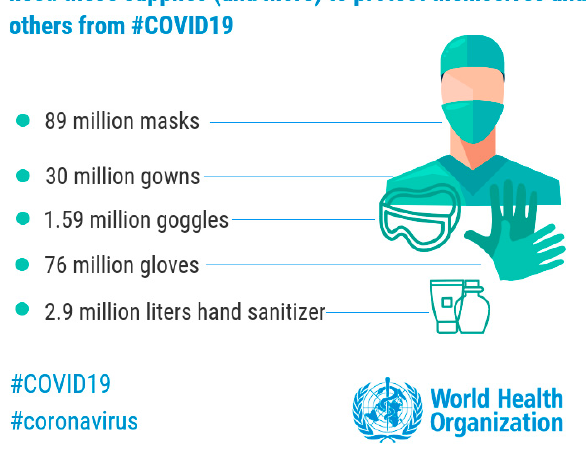
Figure 2. Shortage of medical devices against COVID-19 [2].